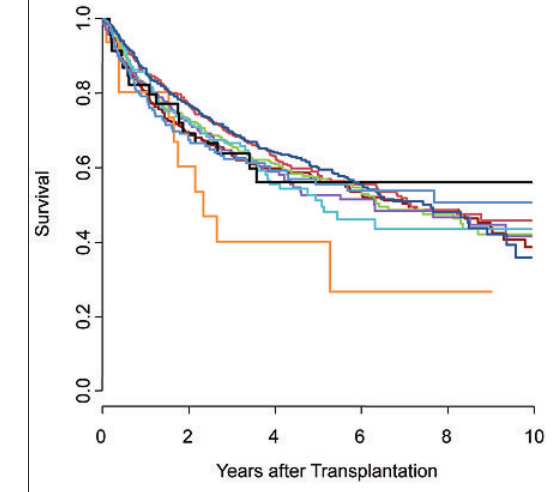
Figure 4b Survival by centre, autologous HSCT.